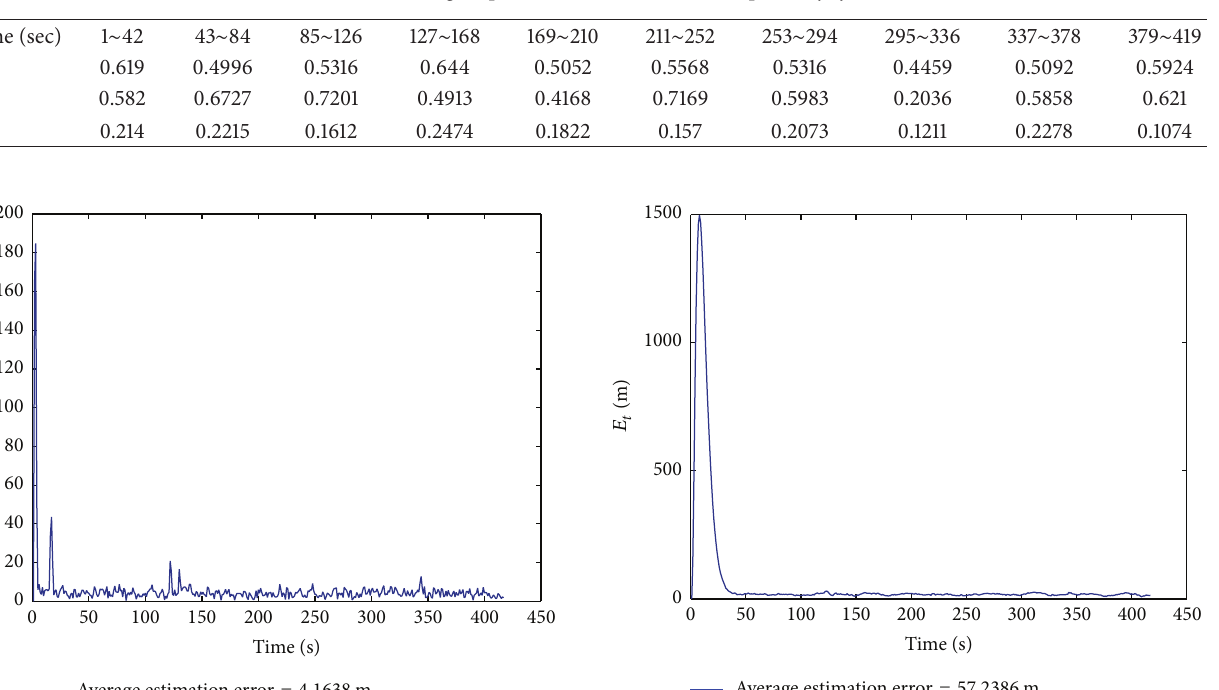
Table 8: Estimated gain parameters for GA based adaptive 𝛼 - 𝛽 - 𝛾 filter.